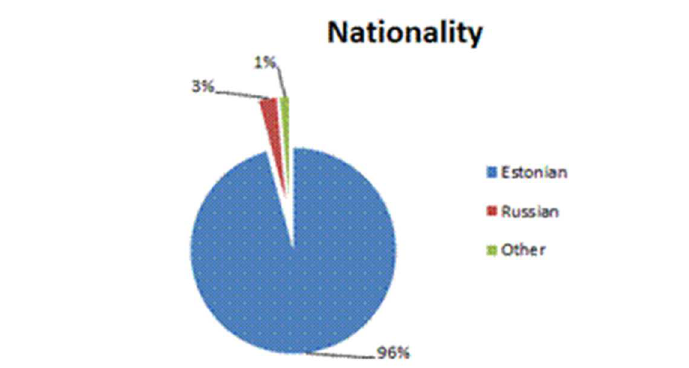
Figure 3 – The nationality of employees in